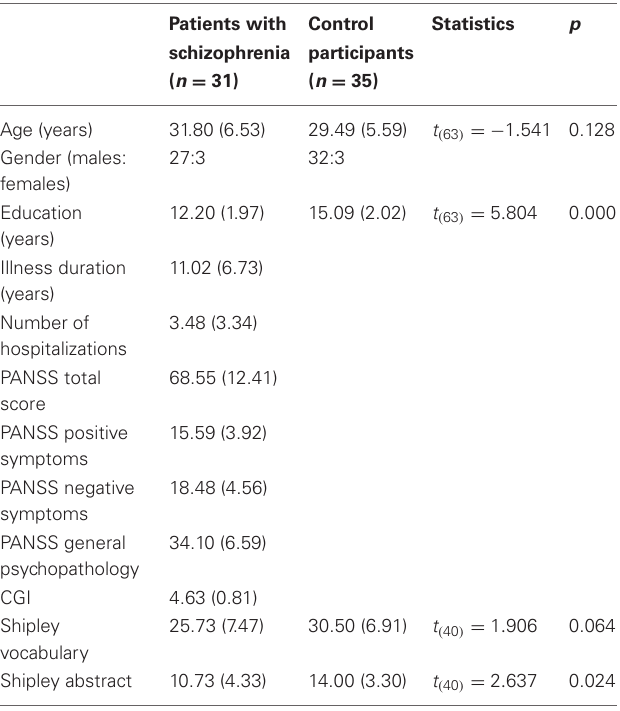
Table 1 | Demographic and clinical characteristics of patients with schizophrenia and